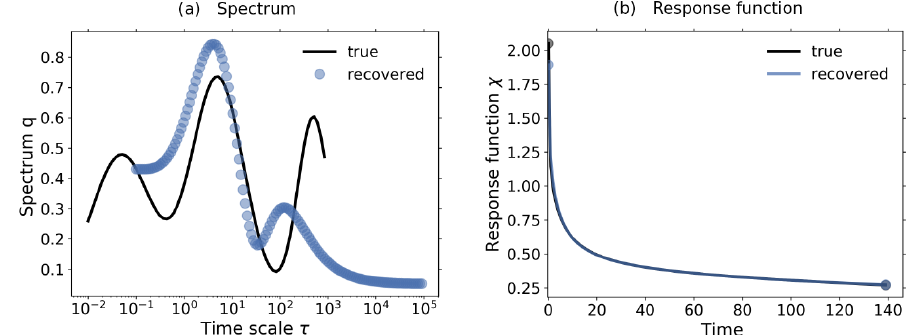
Figure D1. Recovery of spectrum and χ(t) taking a true spectrum with contributions at timescales much longer and much shorter than the timescales covered by data. For the recovery, data with SNR = 6 × 10 4 from the 1% experiment with the toy model (see Part 1) was taken (time series length T = 140 and time step (cid:49)t = 1). RFI parameters are taken as in Part 1 except for M = 140. The recovered spectrum matches only partially the true spectrum. Nevertheless, the response function χ(t) is almost perfectly recovered.